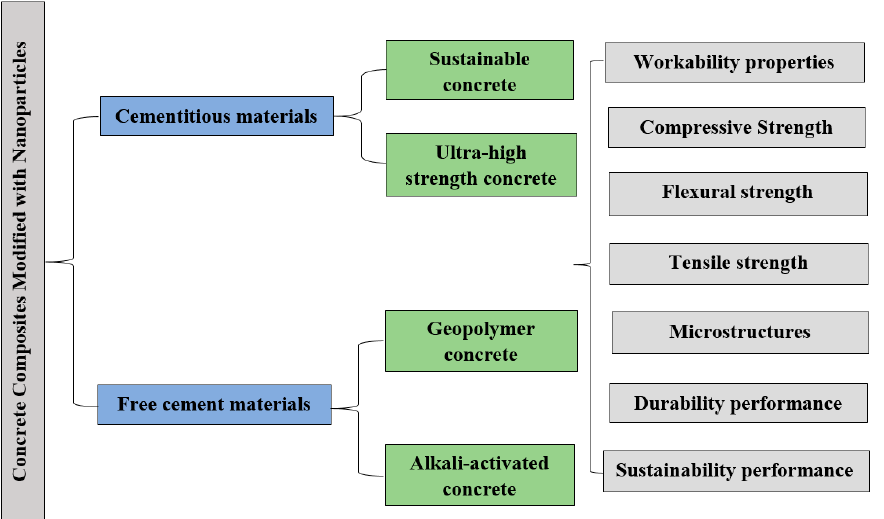
Figure 2. Flowchart of the review of various NP-modified concrete composites.